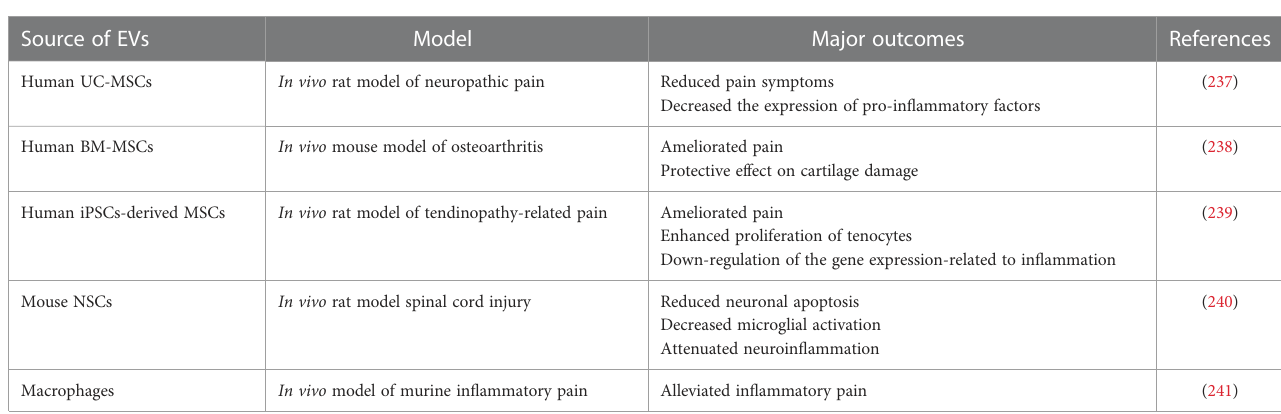
TABLE 8 Examples of EV use in preclinical studies related to the pain